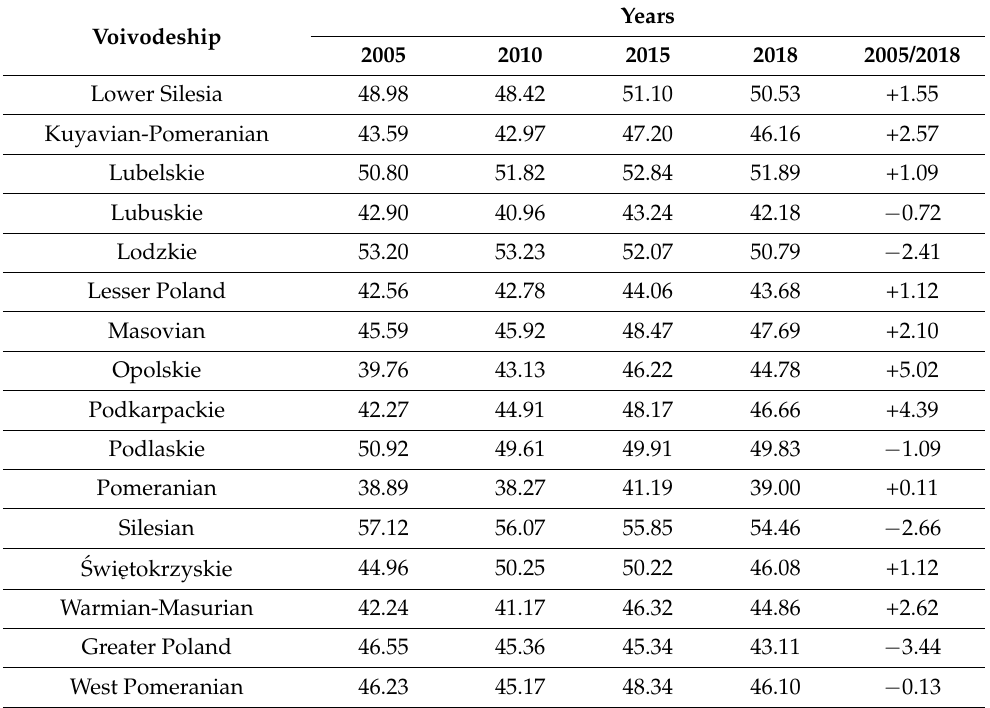
Table 2. Beds in general hospitals per 10,000 people in Poland, broken down by voivodeships, in